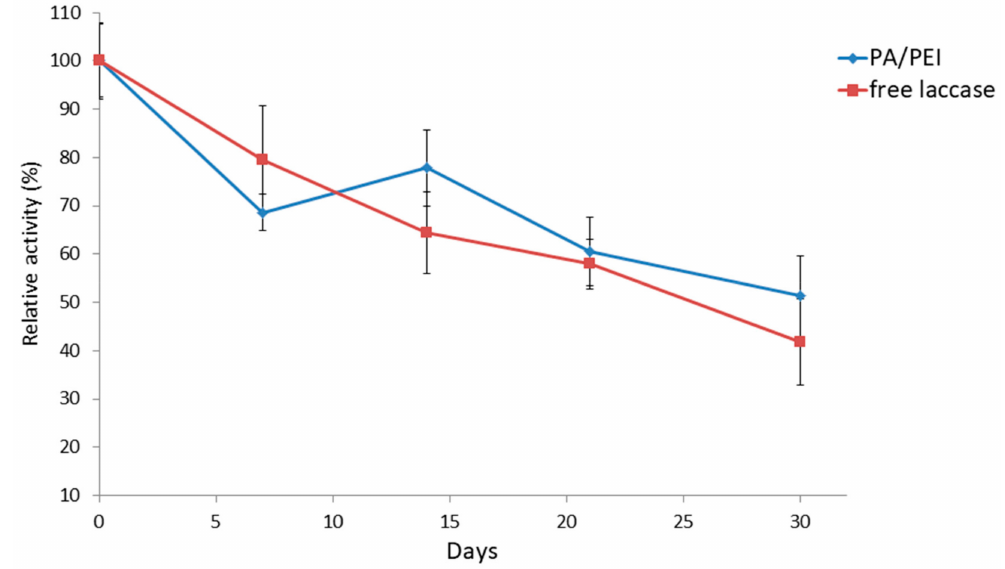
Figure 5. Storage stability of free and immobilized laccase. PA / PEI nanofibers loaded with immobilized laccase were incubated deionized water at 4 ◦ C. Free laccase solution was stored under the same conditions for comparison with the immobilized